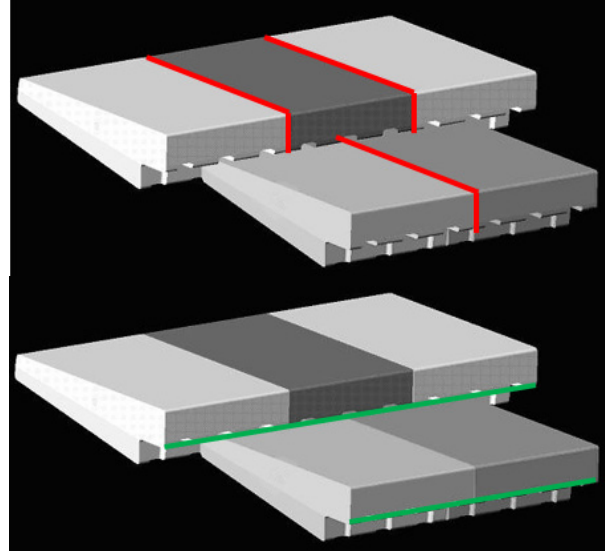
Figure 10. Longitudinal joints (red) and transverse joints (green) between blocks. Adapted from [14].